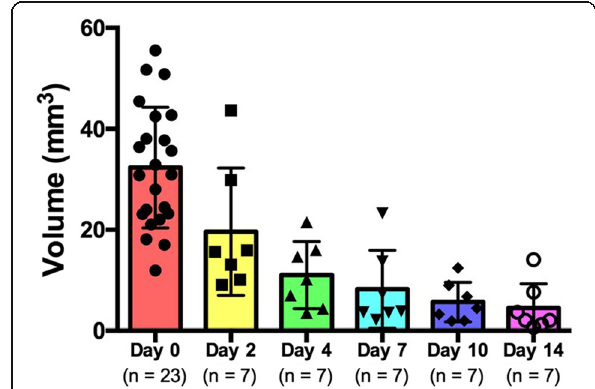
Fig. 3 In vivo three-dimensional skeletal muscle injury volume quantification up to 14 days after injury. This quantification includes both single follow-up ( n = 20) and validation ( n = 3)